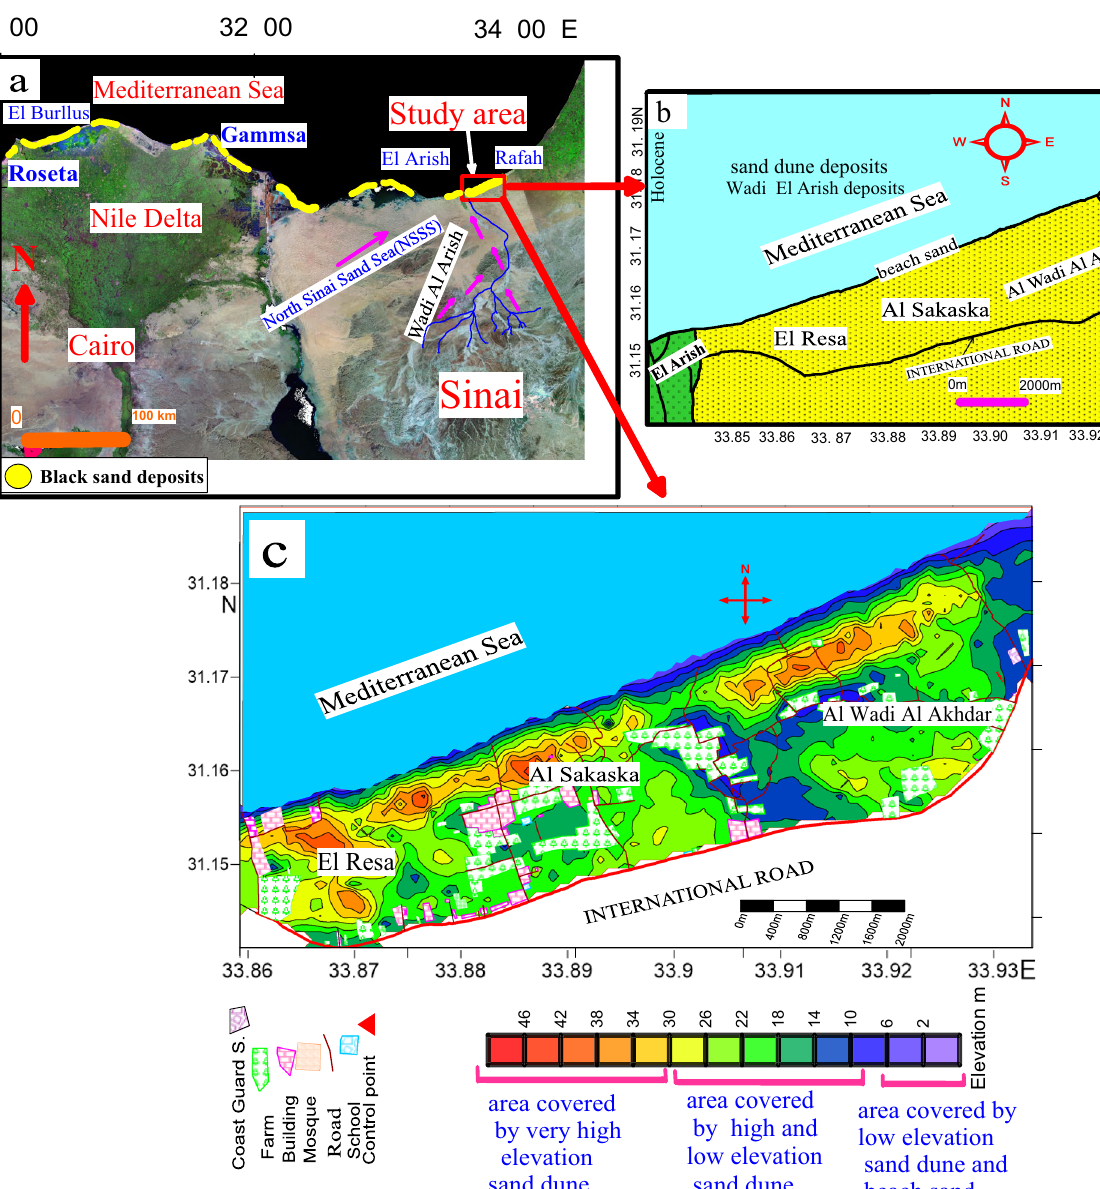
Figure 1. ( a ) Noth Egypt satalight image shows location of the main black sand deposits and the study area. ( b ) Geological map of the study area.( c ) Detailed topographic map illustrate the main deposits for study area (the area only covered by sand dune and beach sand), Map was created by Surfer Software 13.6 (2016) https:// www. golde nsoft ware. com/ produ cts/